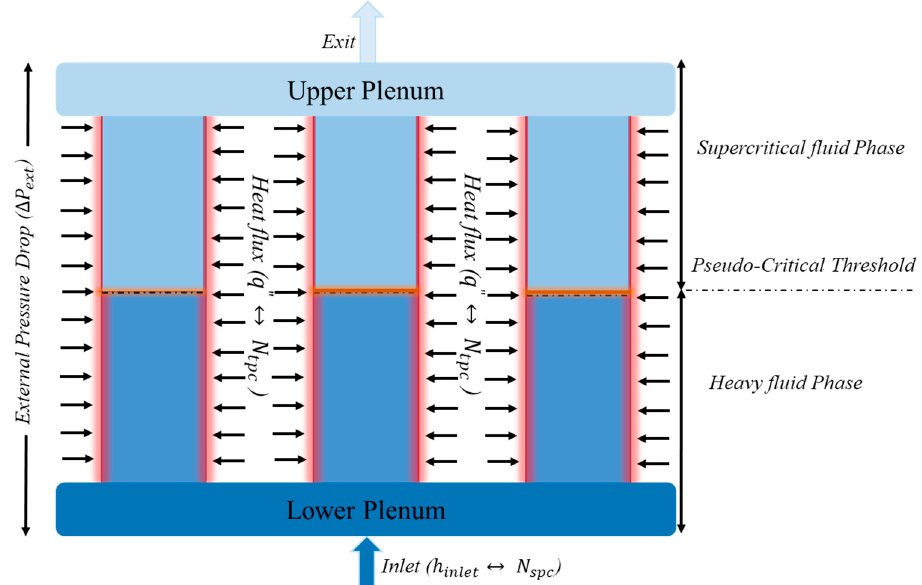
Figure 2. The schematic of three parallel heated channels model proposed in this study.